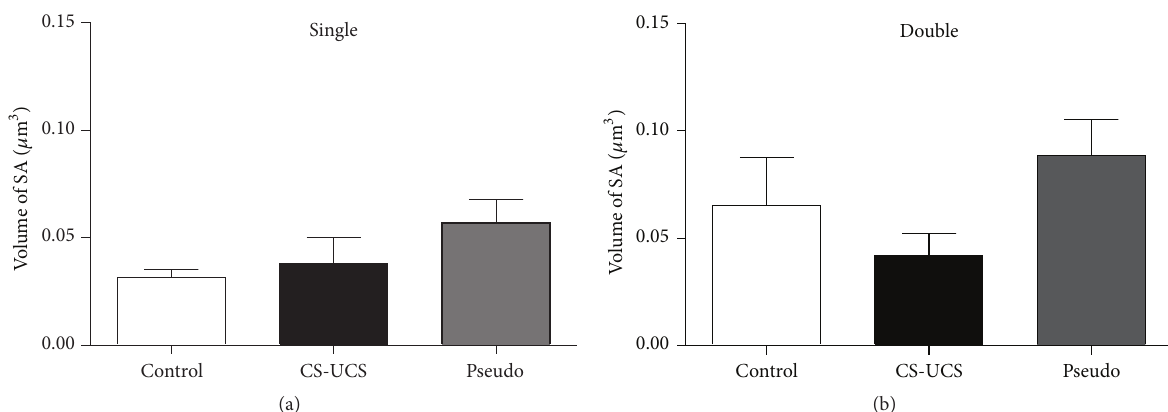
Figure 4: Volume of spine apparatus in single- (a) and double-synapse spines (b). The graphs show means ± SEM (one-way ANOVA with post hoc Tukey’s test).